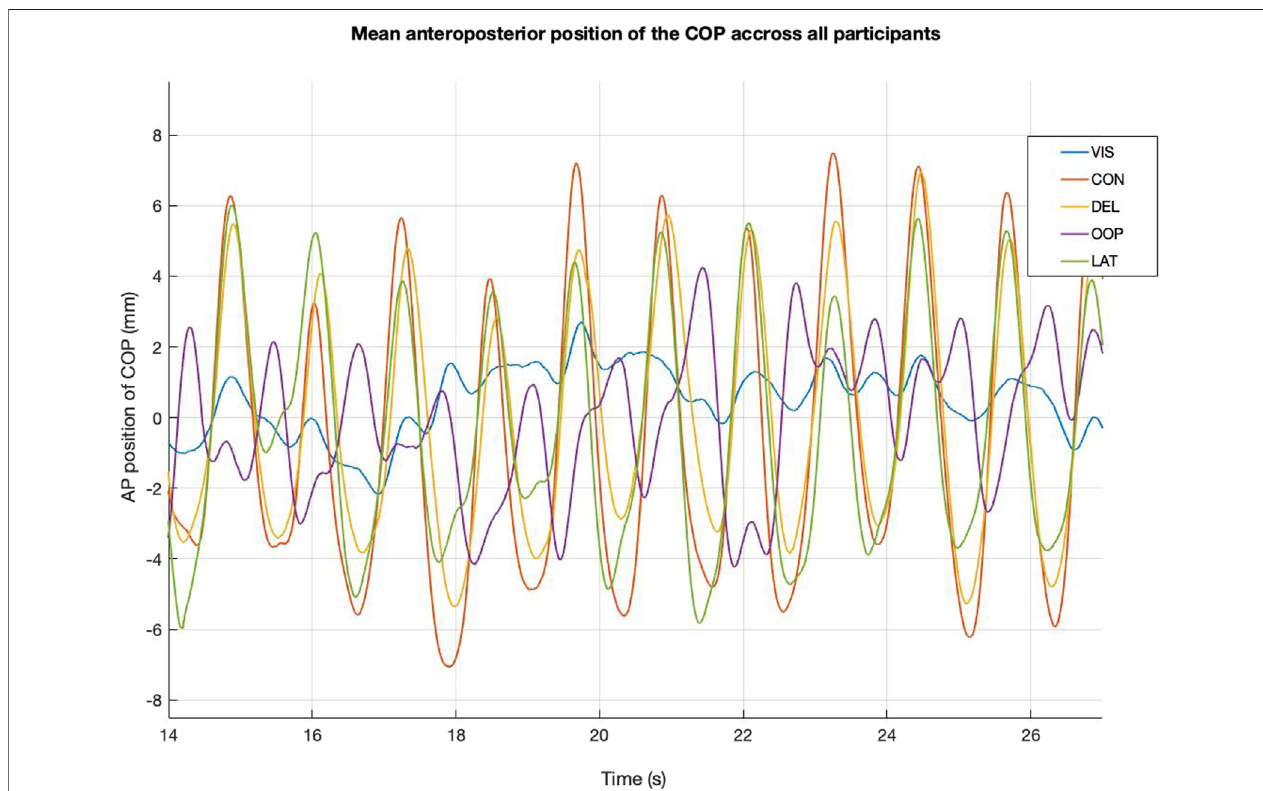
FIGURE 7 | Averaged ( N (cid:2) 30 participants) anteroposterior instant position of the centre ofpressure, presented over 13 s. VIS, Visual-only condition (no vibration); CON, congruent condition; DEL, delayed condition; OOP, out-of-phase condition; LAT, lateralized condition.